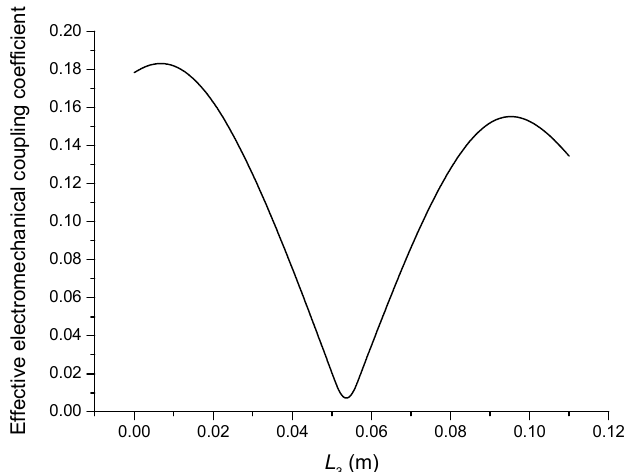
Figure 10. Theoretical relationship between the effective electromechanical coupling coefficient and length L 3 at the second mode (Position effect of PZT-2).